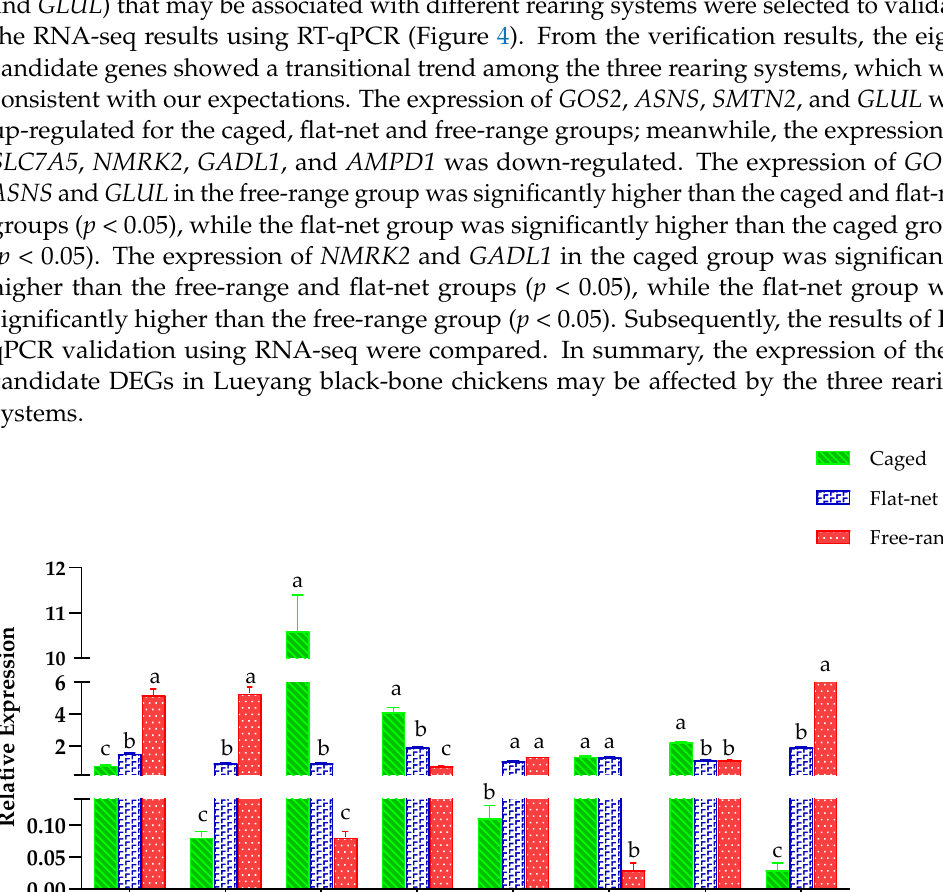
Figure 3. PPI network of candidate differently expressed genes. In the network, the higher the score of the interacting genes, the deeper the color of the lines between them, indicating a stronger inter ‐ action between two genes. The lines are directional, with the source gene pointing to the target gene along the direction of the number on the line. The larger the circle representing the gene, the more the interactions of the gene.